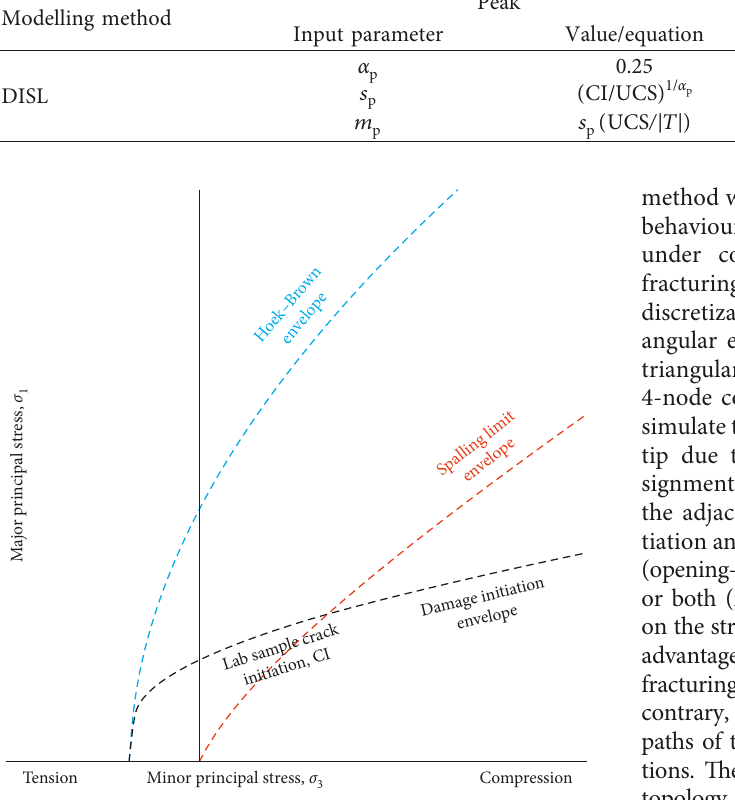
Figure 1: Schematic of the Hoek–Brown criterion strength en- velope and the composite strength envelope of the DISL model [16] (modified after